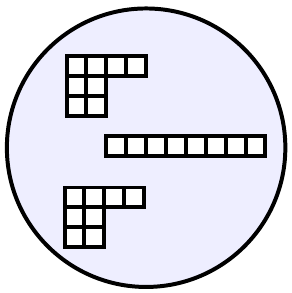
Figure 1. An interacting fixture in the D 4 theory which corresponds to the product of two copies of rank-1 Minahan-Nemeschansky E 6